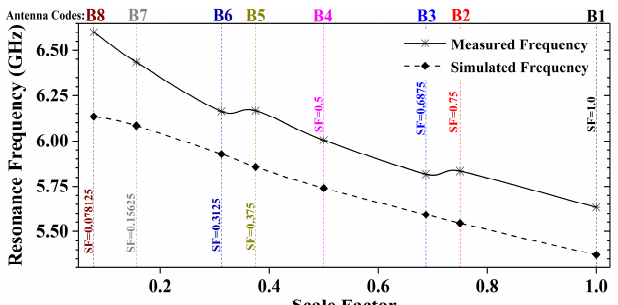
Figure. 4. Deviation of measured resonance frequencies from simulation results.